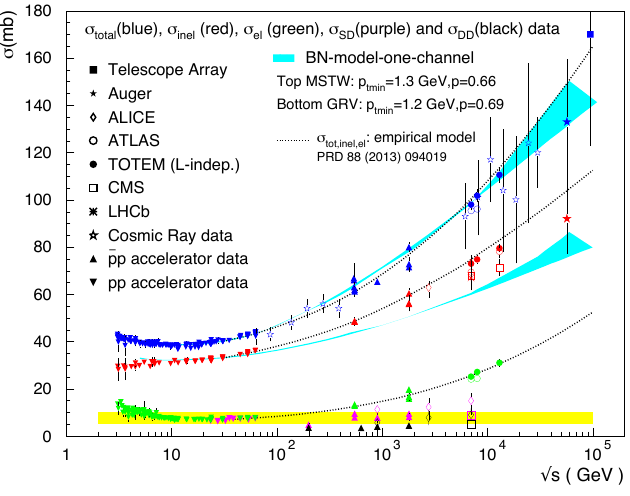
Figure 5. The rise of the total, elastic and inelastic proton proton cross-sections: comparing data with two models described in the